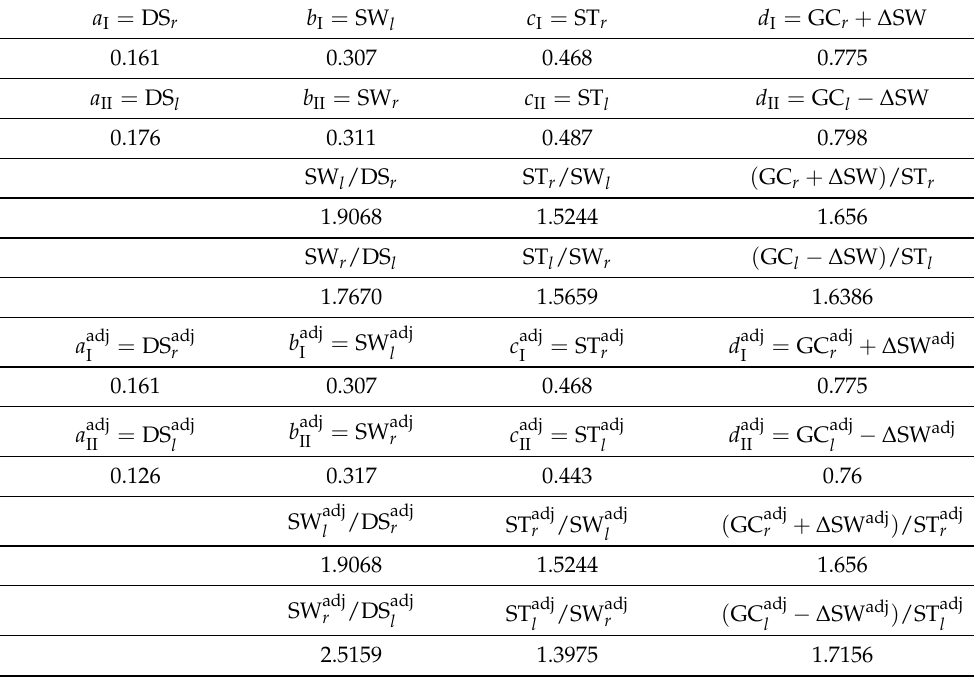
Table 3. Experimental data concerning the elements (in seconds) of the sequences I and II in (3) and their adjoint versions I adj , II adj in (4) for the AT patient G (DS x = 0.077 s, DS y = 0.084